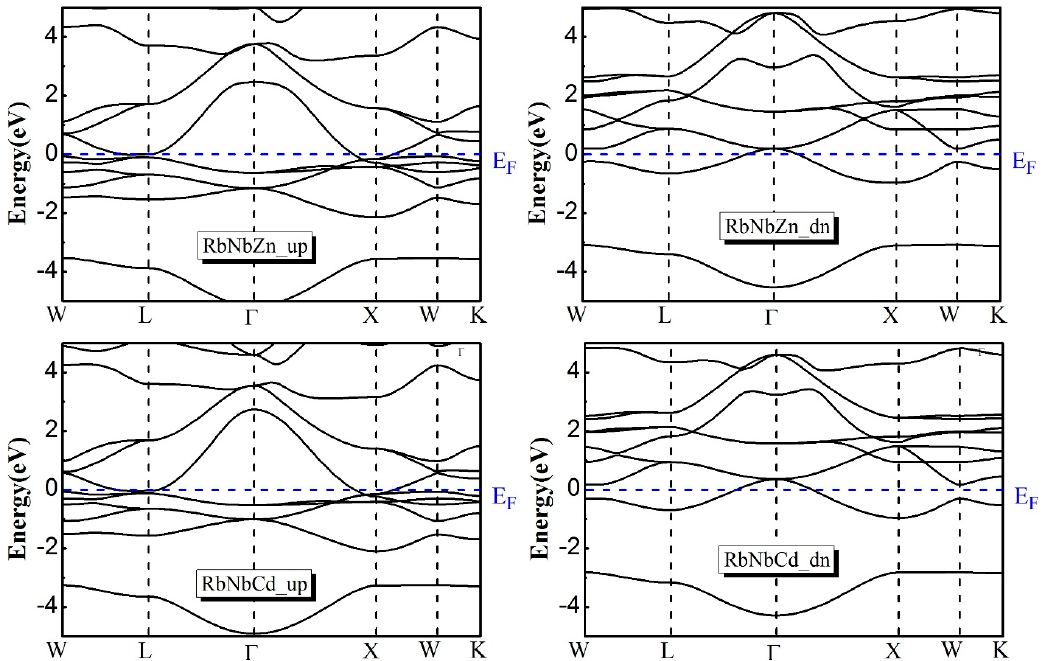
Figure 4. Calculated band structures for RbNbCd and RbNbZn along the high-symmetry axes of the first Brillouin zone.